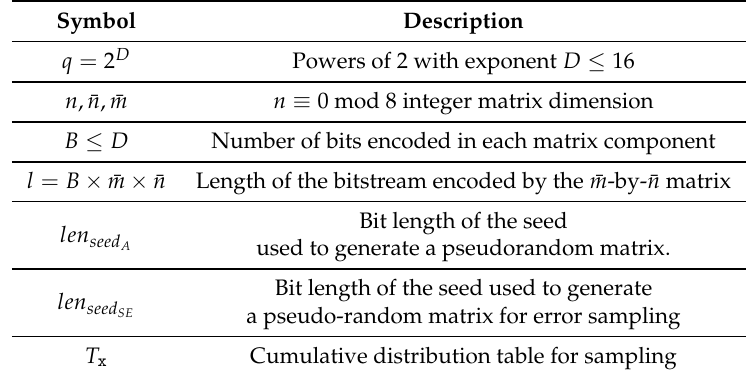
Table 3. Notation of